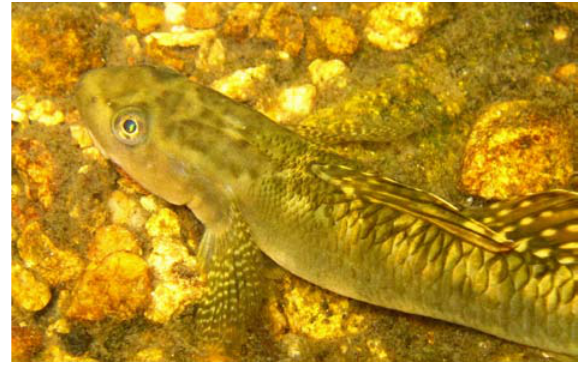
Image 11. Dorsal view of Stiphodon multisquamus (male). Image 12. Dorsal view of Stiphodon multisquamus (another male).